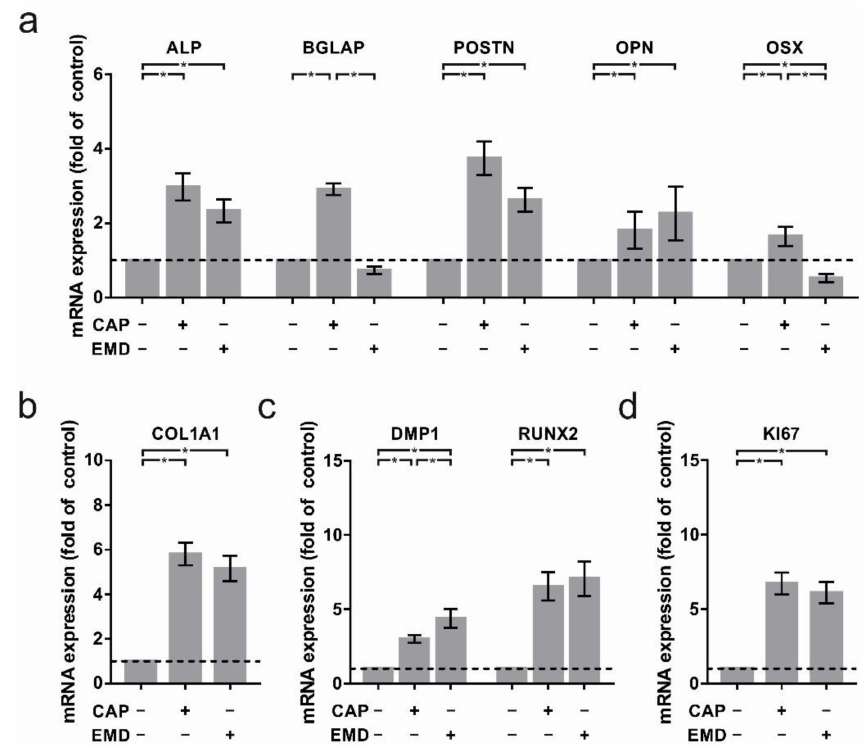
Figure 1. mRNA regulation of crucial markers in OCCM-30 cells after 60 s of CAP and 100 µ g/mL of EMD treatment, respectively (+) as compared to untreated cells ( − ). ( a ) mRNA expression of ALP, BGLAP, POSTN, OPN, and OSX at one day ( n = 15). ( b ) mRNA expression of COL1A1 at one day ( n = 15). ( c ) mRNA expression of DMP1 and RUNX2 at one day ( n = 15). ( d ) mRNA expression of KI67 at one day ( n = 15). * statistical significance ( p <